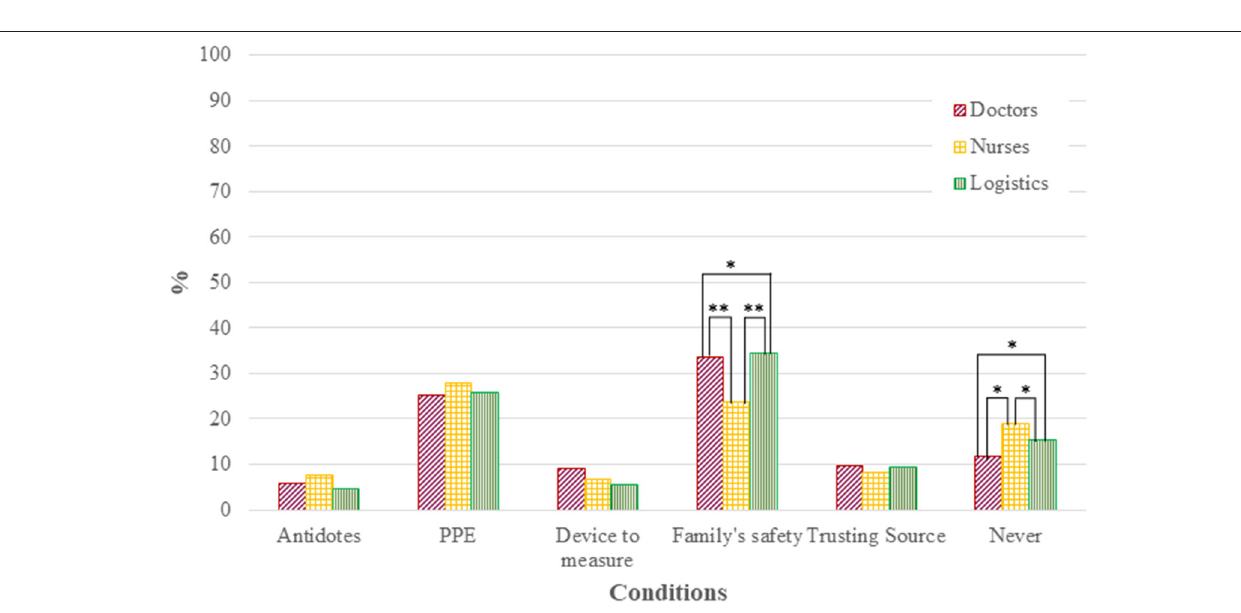
FIGURE 2 | Conditions for willingness to come to work in the event of a nuclear detonation. * p < 0.05, ** p < 0.01. PPE ndicates personal protective equipment. Chart showing response to Question